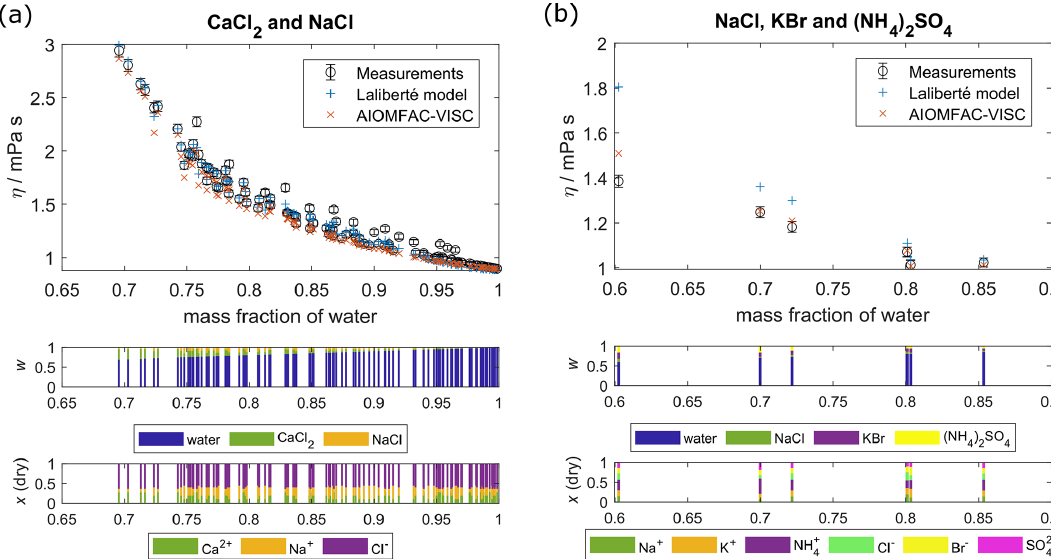
Figure 3. Comparison of AIOMFAC-VISC predictions and Laliberté model results with measured data points for aqueous mixtures of more than one electrolyte: (a) CaCl 2 and NaCl and (b) NaCl, KBr, and (NH 4 ) 2 SO 4 . Middle panel bar graphs show the mass fractions ( w ) with respect to non-dissociated electrolytes, and lower bar graphs show the ion mole fractions with water excluded, x (dry). The 2% vertical error bars are included to represent viscosity measurement